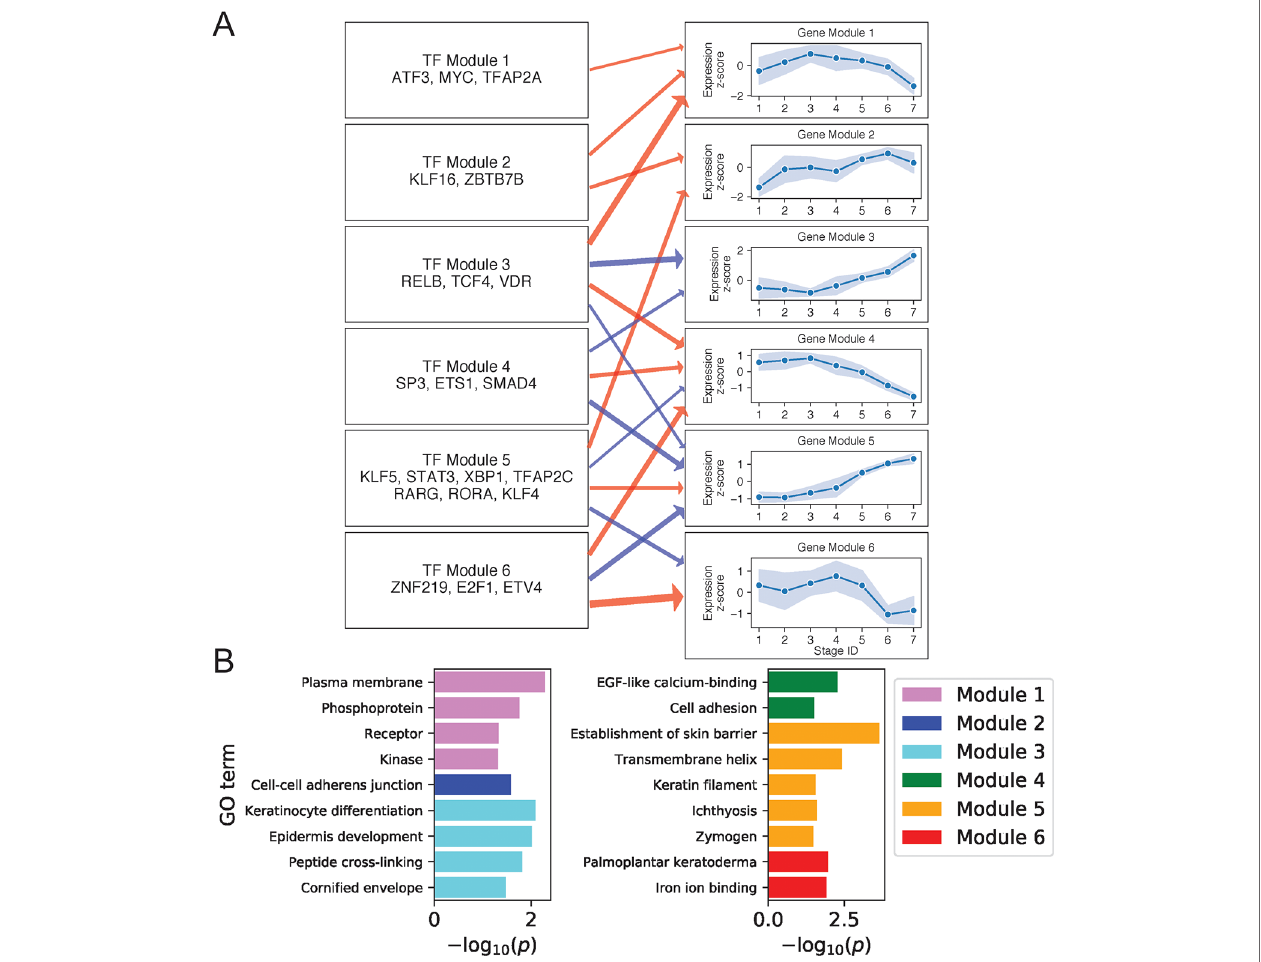
FIGURE 4 | Differentiated keratinocyte network analysis identifies gene and TF modules specific to differentiated functions. (A) Regulation of six GO-enriched gene modules by TF modules, represented as a directed graph. Gene module nodes show log-transformed mean stage-wise imputed expression normalized across stages 1 to 7 with shading of 1 standard deviation interval. Transcription factor modules list their TF constituents. Arrows indicate regulation with width proportional to predicted strength of activation (red) or inhibition (blue). (B) Minus log of adjusted p values for selected GO terms enriched in each gene module. See also Supplementary File 1: Figure S8